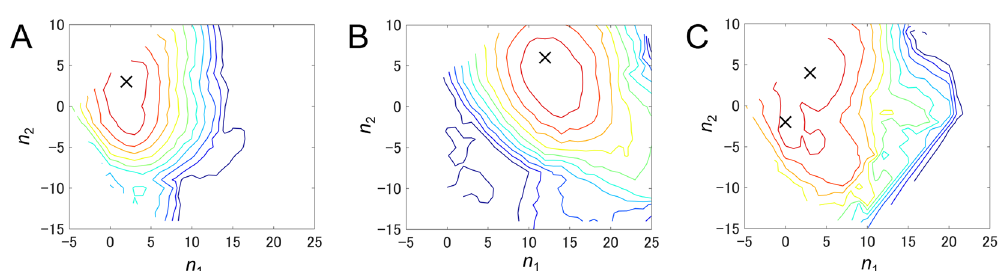
Figure 3. Contour maps of Sc 2 scores for three EM images (( A ) for Ca-006, ( B ) for Ca-020, and ( C ) for Ca-002 in Supplementary Fig. S1) plotted as a function of index numbers n 1 and n 2 for deformed atomic models r 12 ( n 1 , n 2 ). The origin (0, 0) corresponds to the X-ray crystal structure. The contour lines are drawn at an interval of 0.01, starting from the maximum scores. The peaks are indicated by